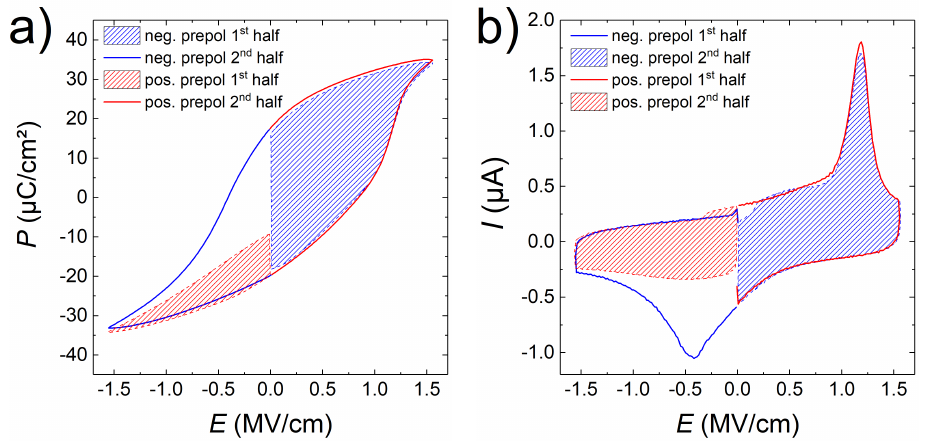
Figure 4. ( a ) P - E and respective ( b ) I - E curves recorded for sample D192 at a maximum voltage of 40V. First (dashed lines, hatched) and second (solid lines) halves of the measurements performed after negative (blue) and positive (red) pre-poling, according to the measurement scheme presented in Figure